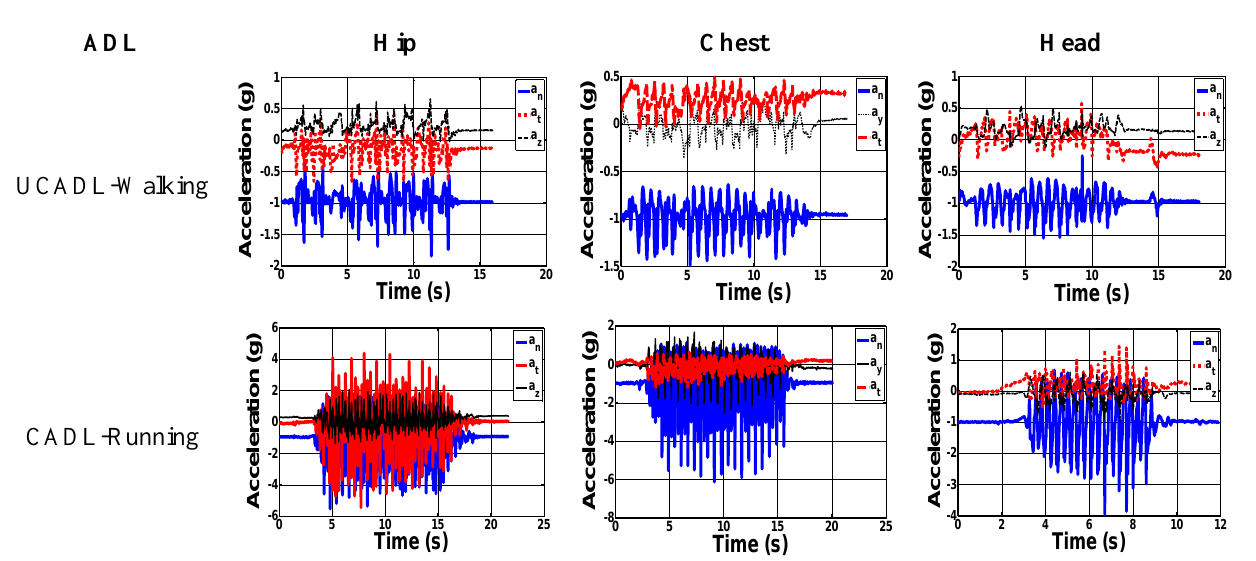
Figure 5. Samples of the CADL and the